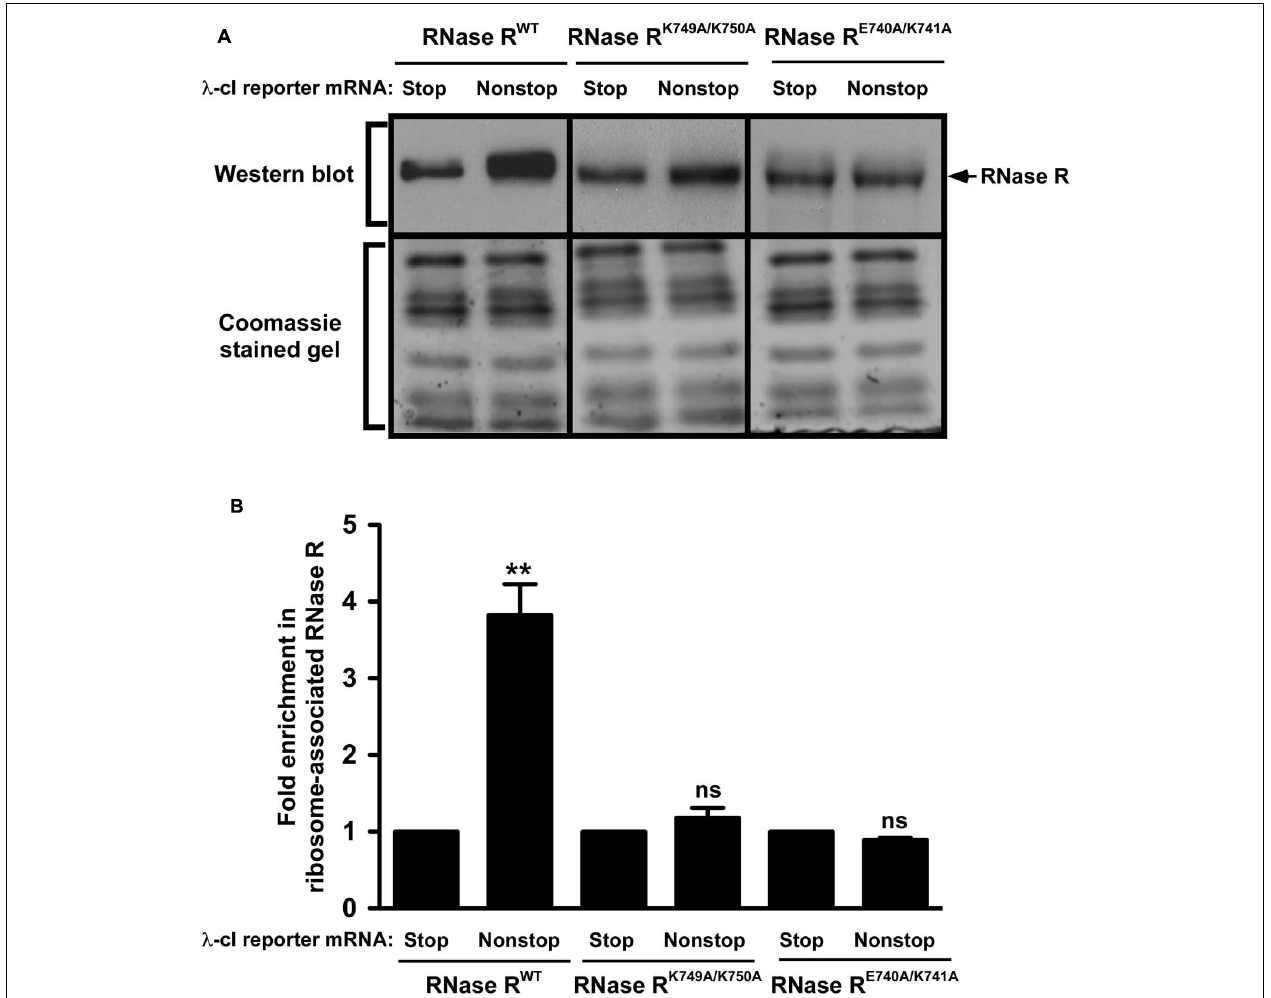
FIGURE 6 | RNase R variants exhibit defects in enrichment on ribosomes translating non-stop mRNA. (A) Total ribosomes were obtained from cells co-expressing indicated RNase R variants with the λ -cI-S or λ -cI-NS reporter mRNAs. Ribosomes translating the reporter RNAs were isolated from the total ribosomes pool using Ni 2 + -NTA affinity chromatography. Equal numbers of ribosomes were resolved by electrophoresis on 10% SDS-polyacrylamide gels.Western blot analysis was performed to detect the presence of RNase R.The intensity of the band corresponding to RNase R was quantified using ImageJ.The top panel shows a representativeWestern blot, using an RNase